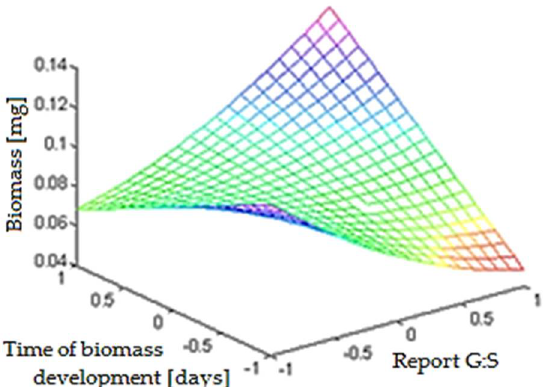
Figure 4. The influence of the time of development of the biomass and the report between glucose and starch when the report between glucose and modified starch is maintained in the field centers. Y = 0.356 + 0.017 · x 2 − 0.043 · x 2